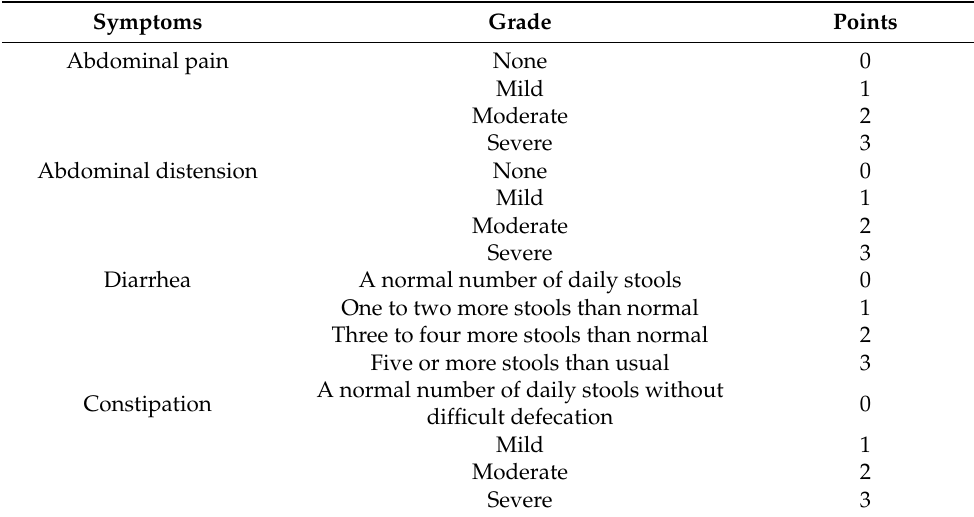
Figure 1. Flow chart of recruitment and randomization of healthy subjects undergoing colonoscopy with carbon dioxide (CO 2 ) or air insufflation. PPI, Proton pump inhibitor. #3–#8, Stool samples were collected on the day of the colonoscopy and 1, 3, 7, 14, and 28 days after colonoscopy. Minor complications: According to previous studies, participants may suffer minor complications, such as abdominal pain, abdominal distension, diarrhea, constipation, defecation discomfort and mucus stool after colonoscopy [14–16]. In the current study, each symptom was divided into four grades: none, mild, moderate and severe, and the changes of symptoms before and after colonoscopy were evaluated according to 0, 1, 2 and 3 scores, respectively. The total score was 0~18 points (Table 1). Symptom assessment time was consistent with fecal sample collection. Table 1. Minor complications were assessed as following symptom